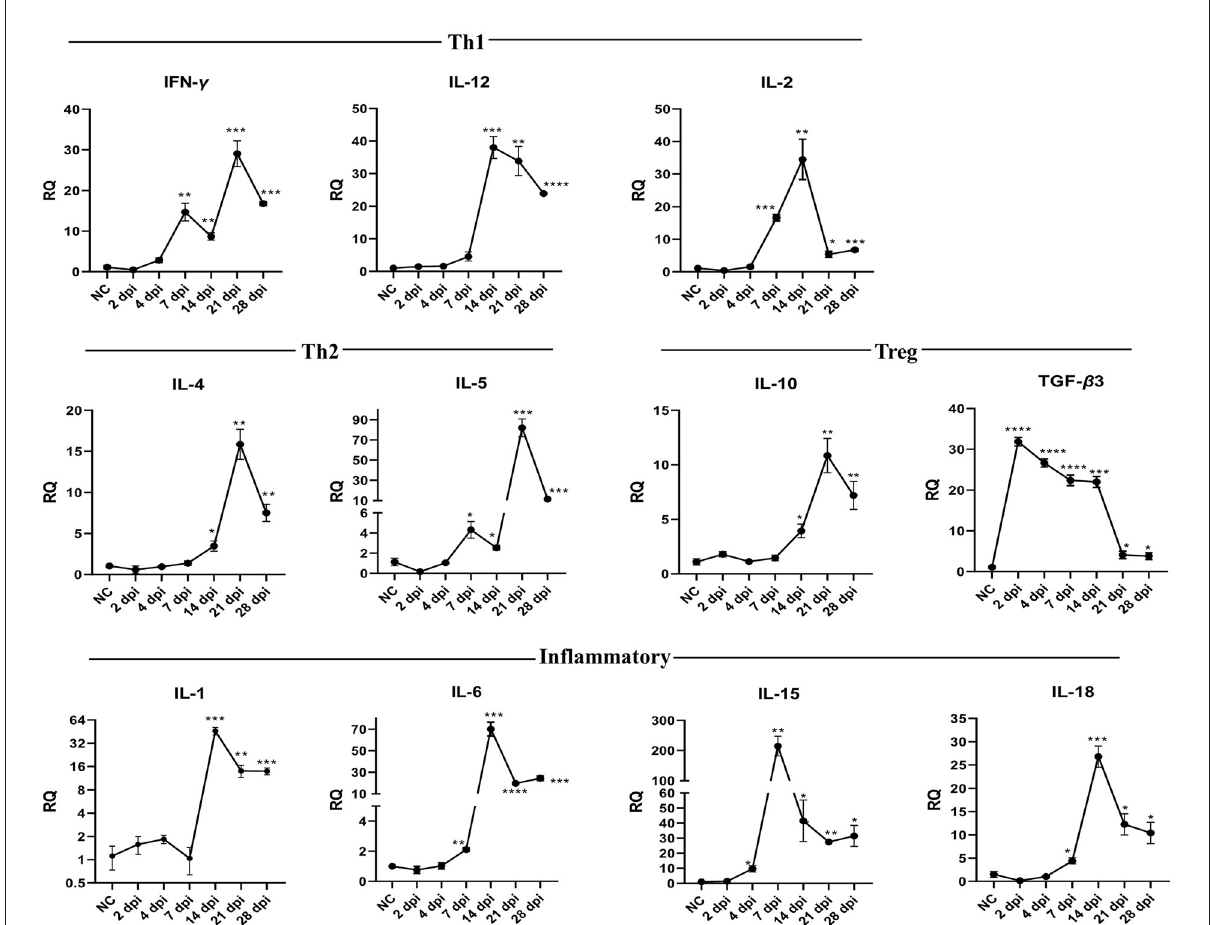
FIGURE6 Temporal changes of the cytokine mRNA expressions in the spleen of pigeons experimentally infected with Prohemistomum vivax. The X-axis represents days post-infection (dpi), and NC refers to negative control uninfected pigeons. The Y-axis represents relative quantities (RQ) of cytokine expression after normalization with β -actin based on the 2 − 11 CT method. Error bars show SEMs. Significant differences between each time-point and negative control (NC) uninfected group: * p < 0.05; ** p < 0.01; *** p < 0.001, or **** p < 0.0001 (using Student T -test).